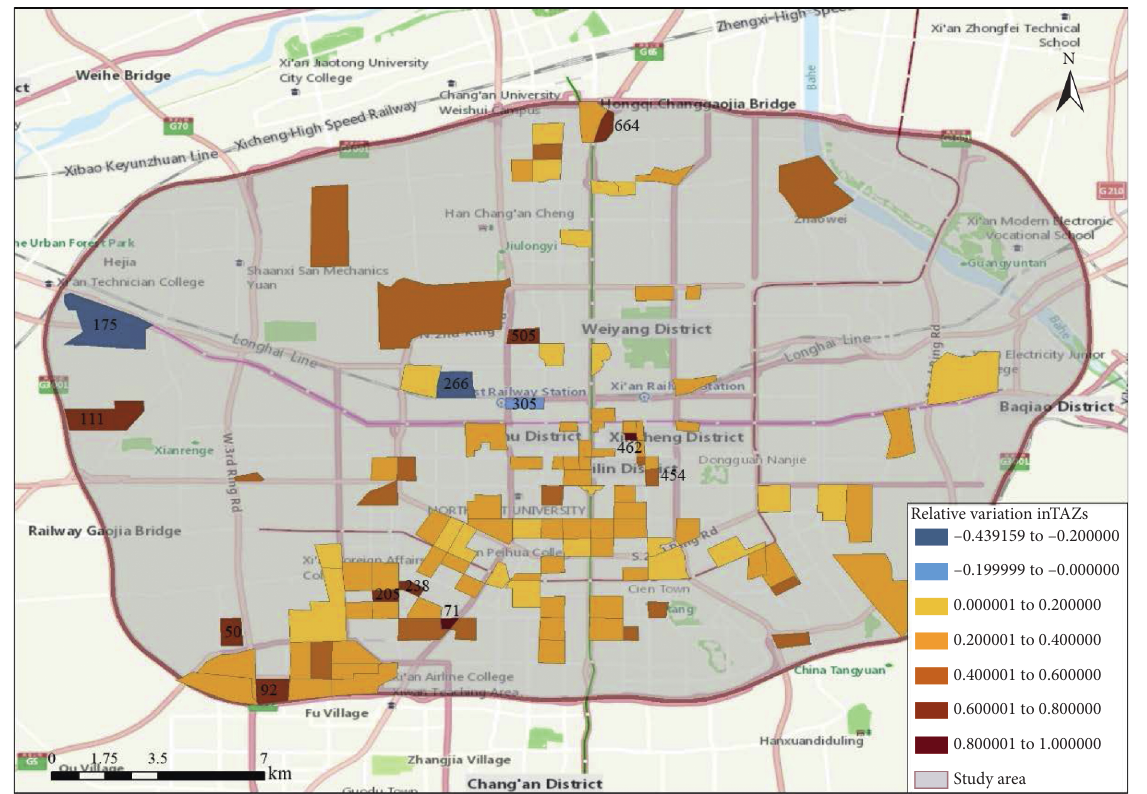
Figure 9: Spatial distribution of relative variation in taxi ridership on